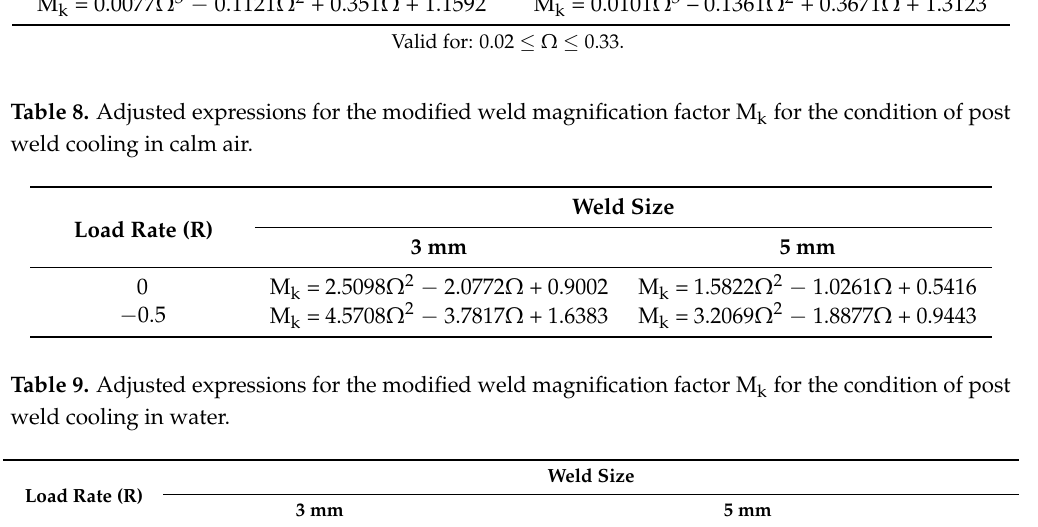
Table 7. Adjusted expressions for the weld magnification factor for the free condition of residual stresses. Weld Size (Leg) 3 mm